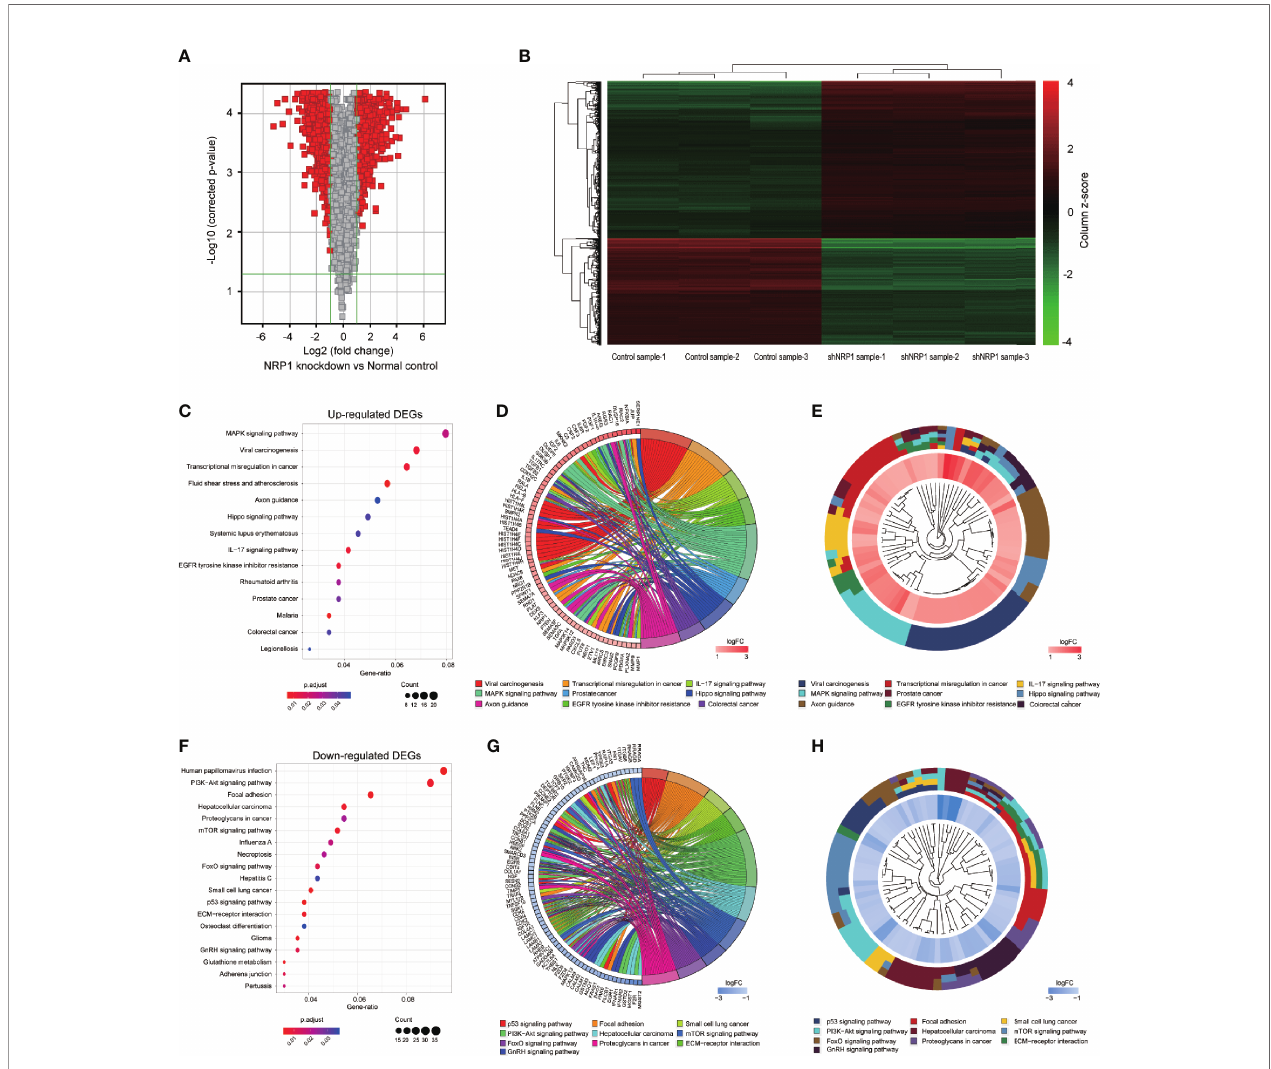
FIGURE 4 | KEGG pathway analysis of DEGs following knockdown of NRP1. (A) Gene expression volcano plot of T24 cells transfected with NRP1 shRNA and a control shRNA vector. The red color on the left side represents 599 upregulated genes, and that on the right side represents 880 downregulated genes (log 2 FC> 2 and p -value < 0.05). (B) Heatmap and hierarchical cluster analysis of T24 cells transfected with NRP1 shRNA and a control shRNA vector. Column represents sample, and row represents gene, green represents a lower level gene expression, and red represents a relatively higher of gene expression. (C) Bubble plot of KEGG pathway analysis of upregulated DEGs. KEGG pathway description was assigned to y-axis and gene ratio was assigned to horizontal axis as the proportion of differential genes in the whole gene set. The dot size represents the gene counts in a certain pathway. (D) KEGG Chord plot of the relationship between the enrichment pathways and their corresponding genes in the upregulated DEGs list. A gene was linked to a certain pathway by the colored bands, and blue-to-red coding next to the genes indicates log FC. (E) KEGG Cluster of the upregulated DEG grouped by their functional categories. The inner ring shows the color-coded logFC, and the outer ring represents the assigned signaling pathways. (F) Bubble plot, (G) KEGG Chord plot, and (H) KEGG Cluster plot of KEGG pathway analysis of downregulated